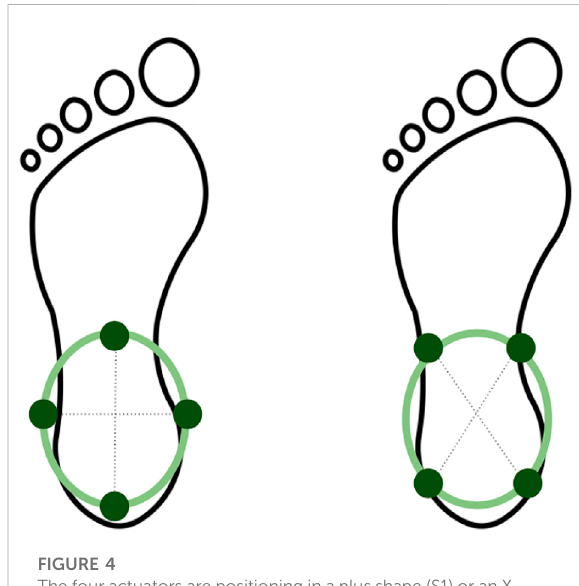
FIGURE 4 The four actuators are positioning in a plus shape (S1) or an X shape